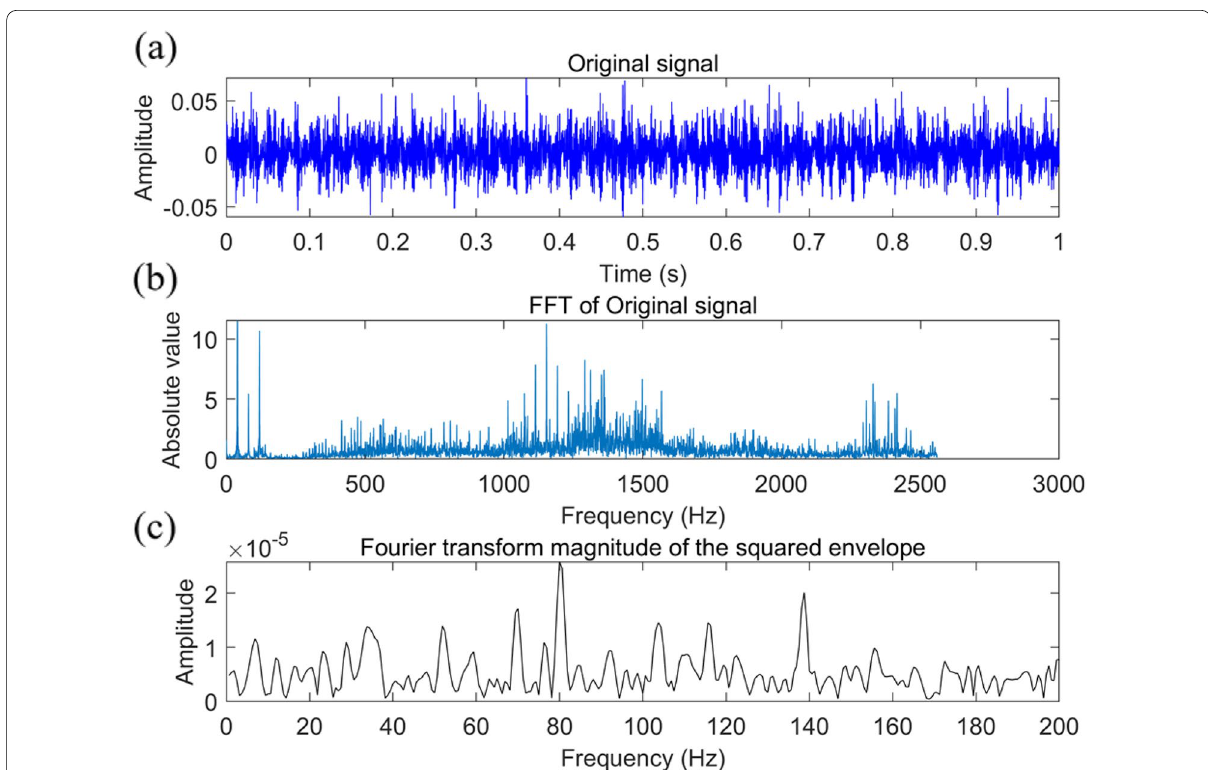
Figure 26 ( a ) Time waveform of the root crack fault signal, ( b ) frequency spectrum of the root crack fault signal, and ( c ) squared envelope spectrum of the root crack fault